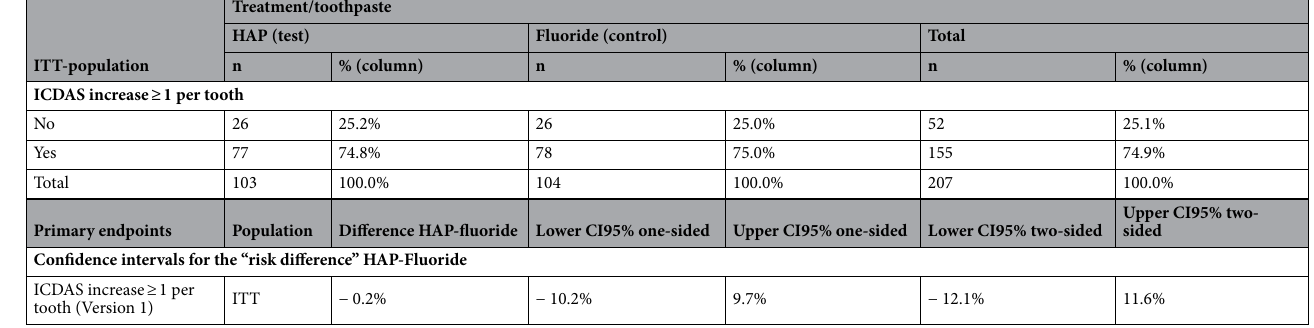
Table 3. Development of enamel caries lesions with ICDAS code ≥ 1 or the progression of an existing enamel caries lesion by at least one ICDAS code in the ITT-population and confidence intervals for the “risk difference”. CI95%, confidence interval; ITT, intent-to-treat; HAP, hydroxyapatite.